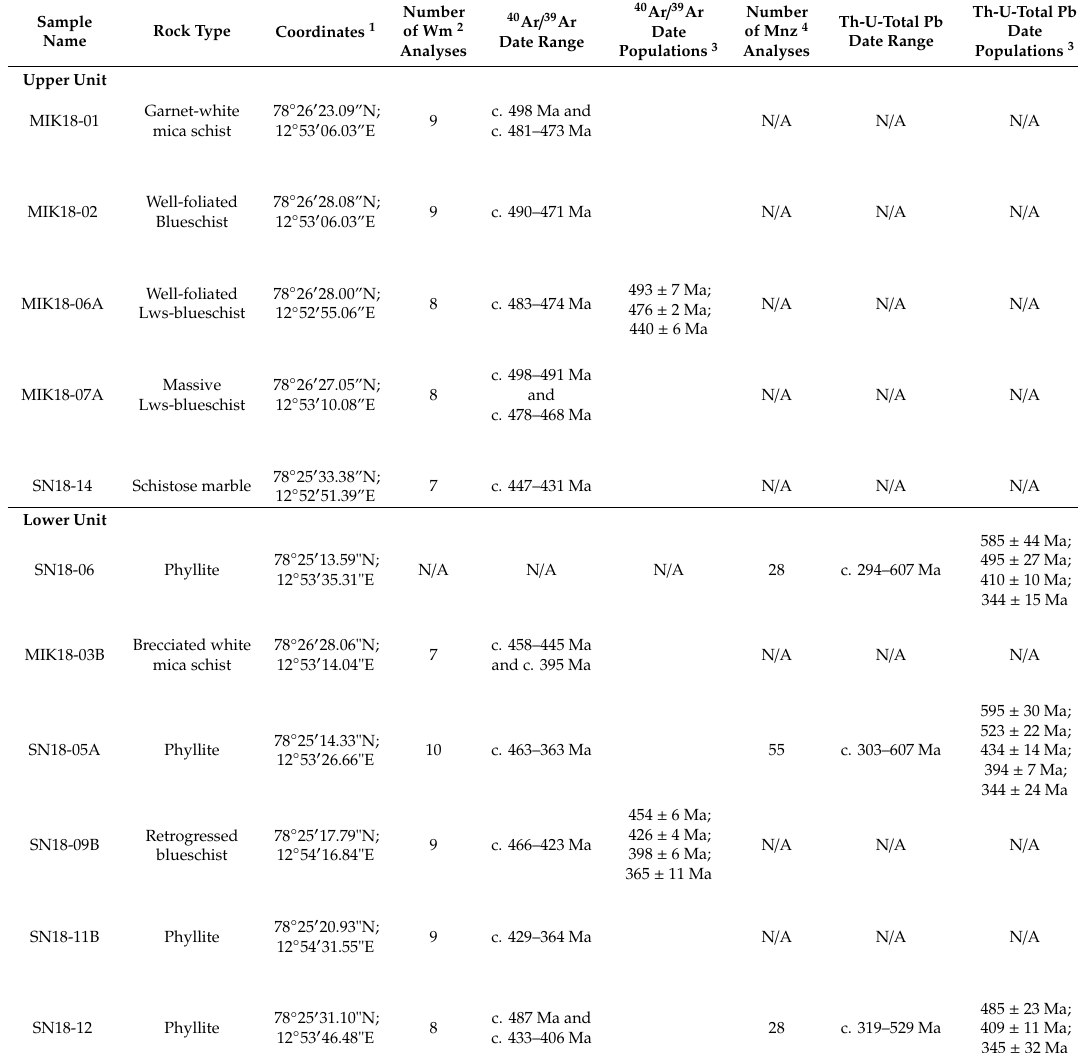
Table 1. Summary of geochronological results for all